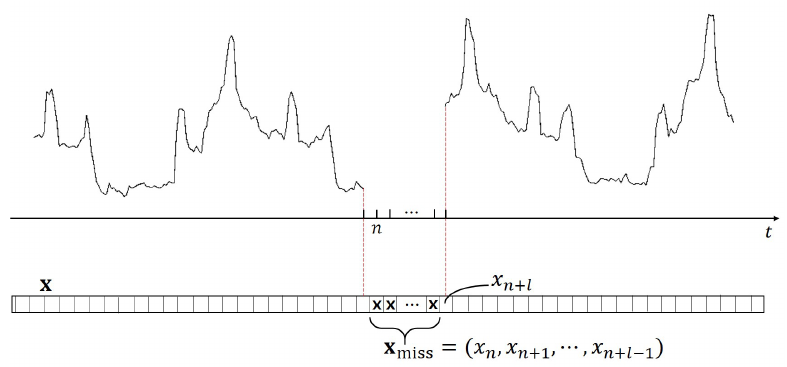
Figure 1. Example of collected power data and missing data.